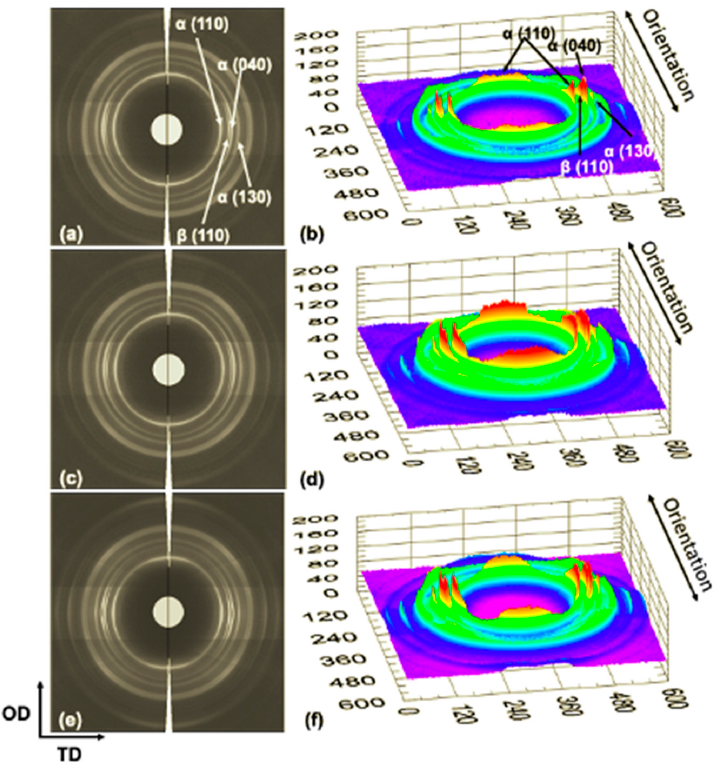
Figure 4. 2D and 3D WAXS patterns of the iPP probes injected at constant amplitude (80%) and different times: ( a , b ) 3 s, ( c , d ) 5 s, and ( e , f ) 6 s. The primary crystalline reflections of the α crystalline phase: (110), (040), and (130), and the β crystalline phase (300) of iPP are also shown.